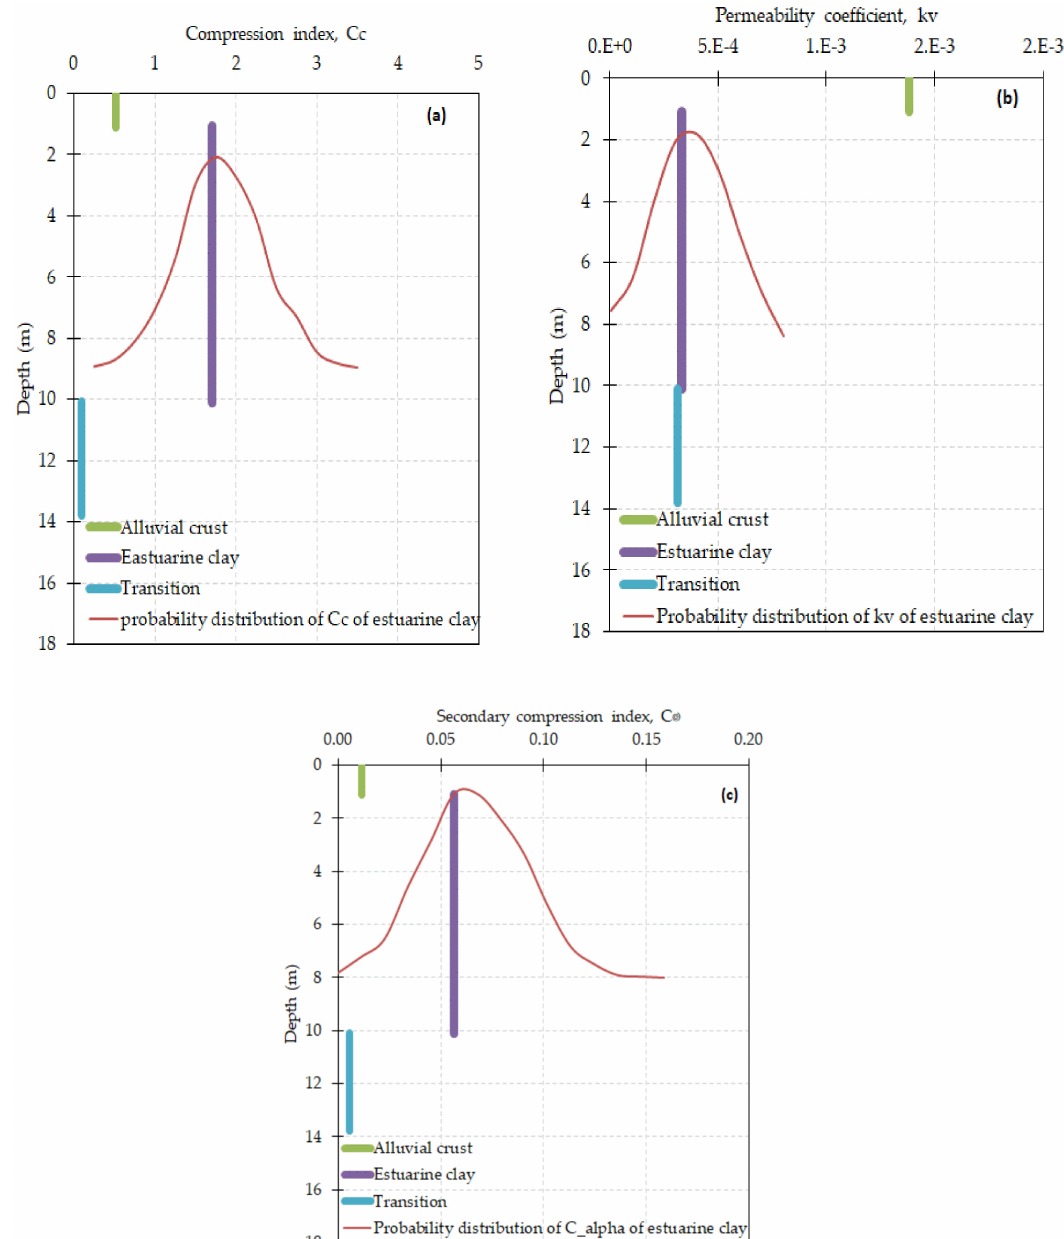
Figure 3. Mean values of model parameters for di ff erent layers and probabilistic distribution for the most influential layer (estuarine clay)) of Ballina clay ( a ) Compression index ( b ) Secondary compression index ( c ) vertical coe ffi cient of